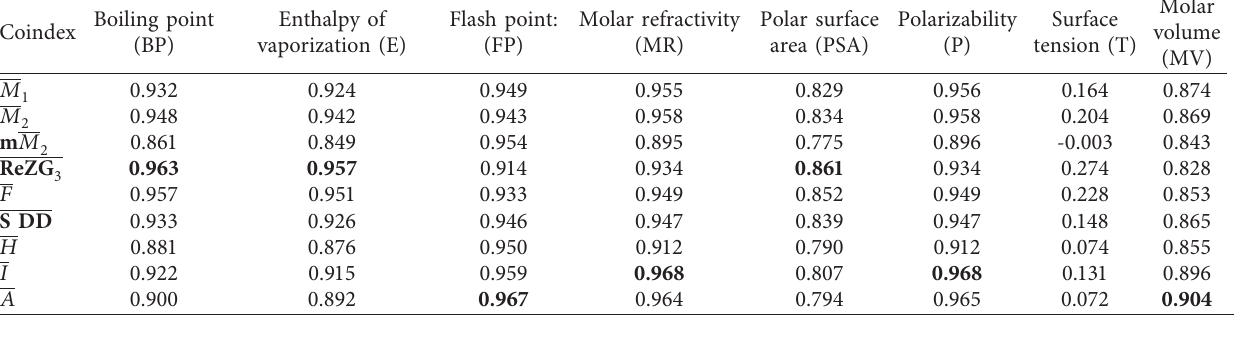
Table 4: The linear regression model’s correlation coefficient ( r ) between topological coindices and physicochemical features of